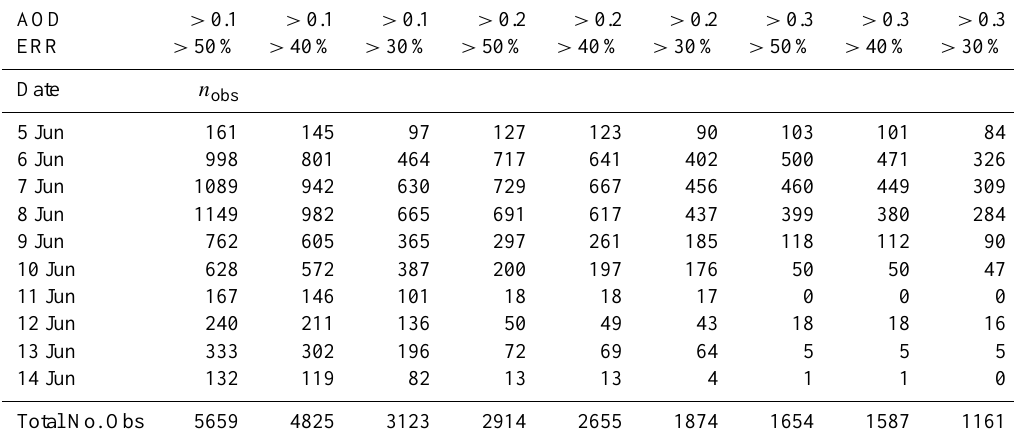
Table 2. Sensitivity of the number of IASI observations to aerosol optical depth thresholds (AOD) and maximum retrieval uncertainty (ERR) for the eruptive period from 5 June to 14 June 2011. For the analysis the threshold values for aerosol optical depth vary between 0.1 and 0.3 and the retrieval uncertainty between threshold values ranging from 30% to